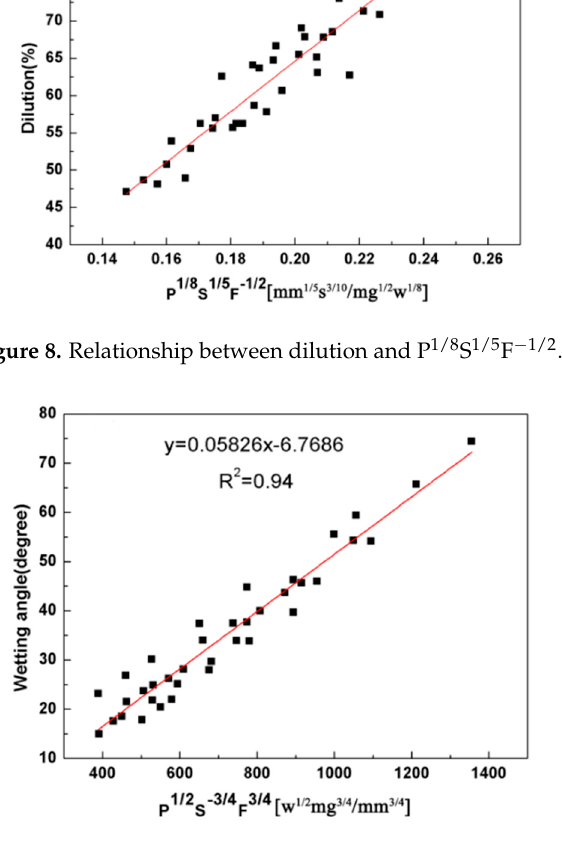
Figure 9. Relationship between dilution and P 1/8 S 1/5 F − 1/2 .